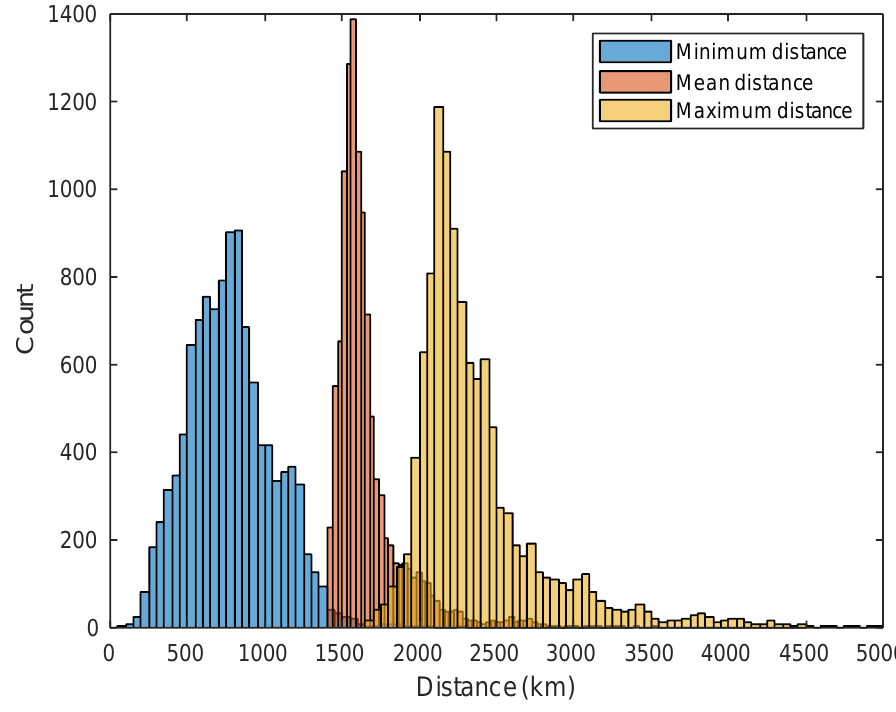
Figure 5. The histograms of the minimum, mean and maximum distances from the lightning events to the four stations of ELLN. The maximum distance from a lightning event to the ELLN stations is defined as the distance from the event to the ELLN network. For all the lightning localization events in Figure 3, we sorted the localization errors obtained from each group velocity estimation method by distance from near to far and counted the mean and the standard deviation of localization errors per 200 km interval within 1500 to 4000 km, and the results are shown in Figure 6. Note that in Figure 6, the mean and standard deviation of the localization error correspond to the left and right y- axes respectively. From the figure, it can be seen more clearly that the four group velocity estimation methods, in descending order of localization error, are arranged as follows: the speed of light in the air ( v 1 ), the group velocity of the first-order mode ( v 2 ), the group velocity estimated by LWPC ( v 3 ), and the group velocity estimated by LWPC and IRI ( v 4 ). This is the same as the conclusion obtained in Figure 4. Among them, v 1 has the largest localization error due to the use of the speed of light in air, with an error range of 13 – 30 km; v 2 has the second largest localization error, with an error range of 4 – 17 km; v 3 has the third largest localization error, with an error range of 3 – 14 km; and v 4 has the smallest localization error, with an error range of 2 – 10 km.